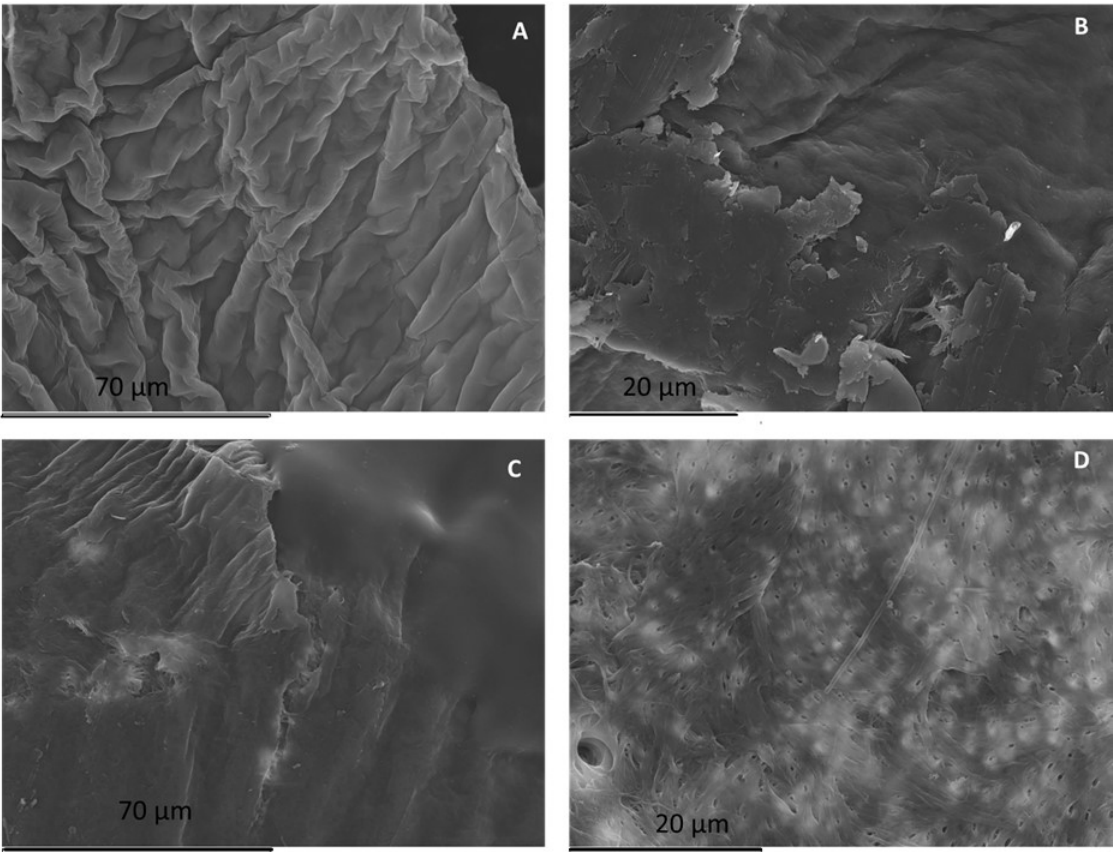
Figure 4. SEM images of chitin ( A , B ) and chitosan ( C , D ). Bar 70 µm in left panel and 20 µm in right panel.